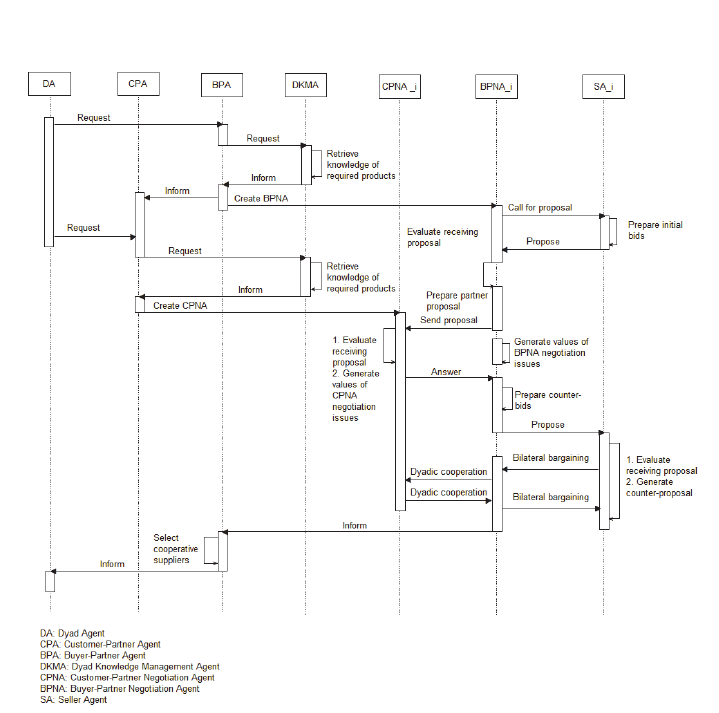
Fig. 9. Hybrid protocol of the proposed model